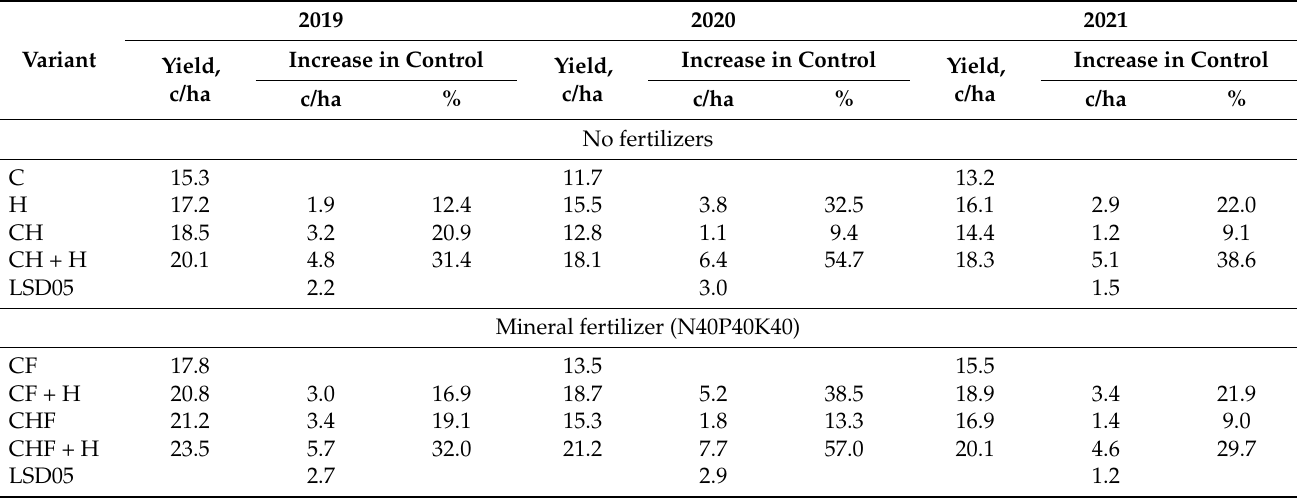
Table 5. Yield of peas by variants of the experiment with a humic